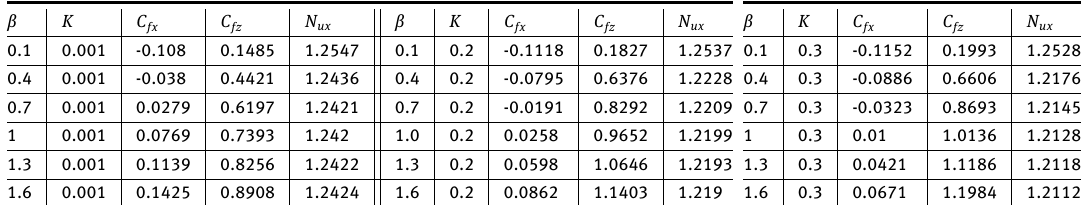
Table 3: Variation of quantities of interest with Casson fluid parameter m = 0.3000 , χ = 0.1000 , Gr = 3 , and Pr = 1.3800